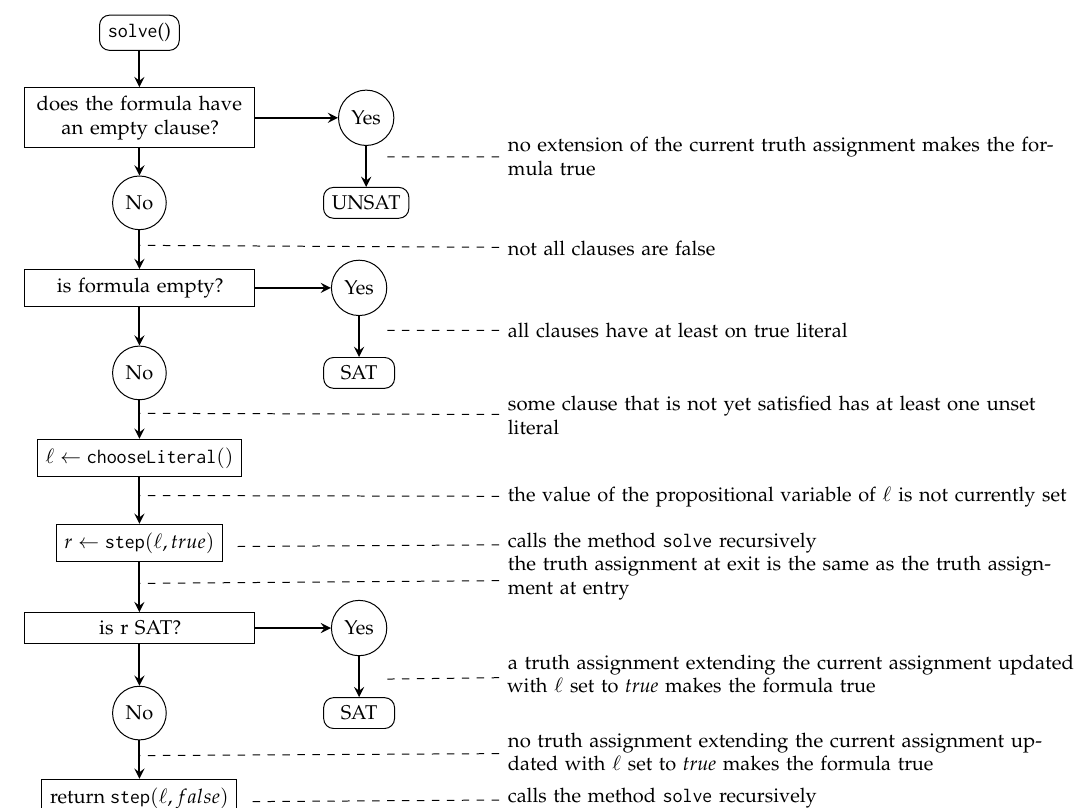
Figure 5. Flowchart of method solve . A level-0 propagation of unit clauses is performed just before the call to the solve method and is not shown in the